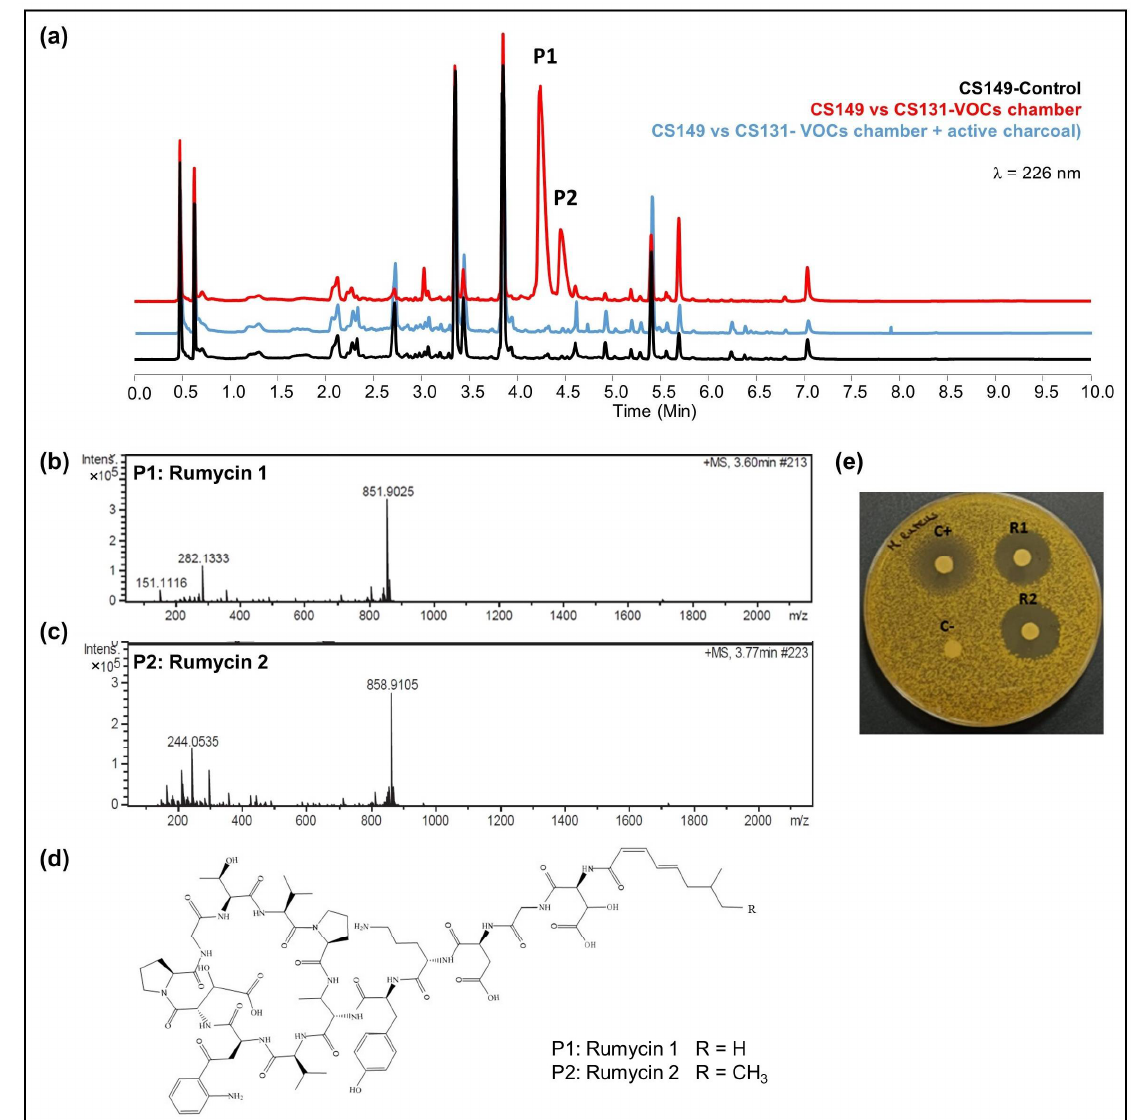
Figure 5. Activation of the synthesis of rumycins by the effects of VOCs from Streptomyces sp. CS131 on CS149. ( a ) Comparative UPLC profile where the peaks containing rumycin 1 and rumycin 2 have been numbered as P1 and P2, respectively; ( b ) HRMS spectrum of rumycin 1; ( c ) HRMS spectrum of rumycin 2. ( d ) Chemical structure of rumycins. ( e ) Bioassay of purified rumycins against M. luteus . (C + ): apramycin (200 mg/mL), (C − ): methanol, (R1): rumycin 1 (10 mg/mL), (R2): rumycin 2 (10